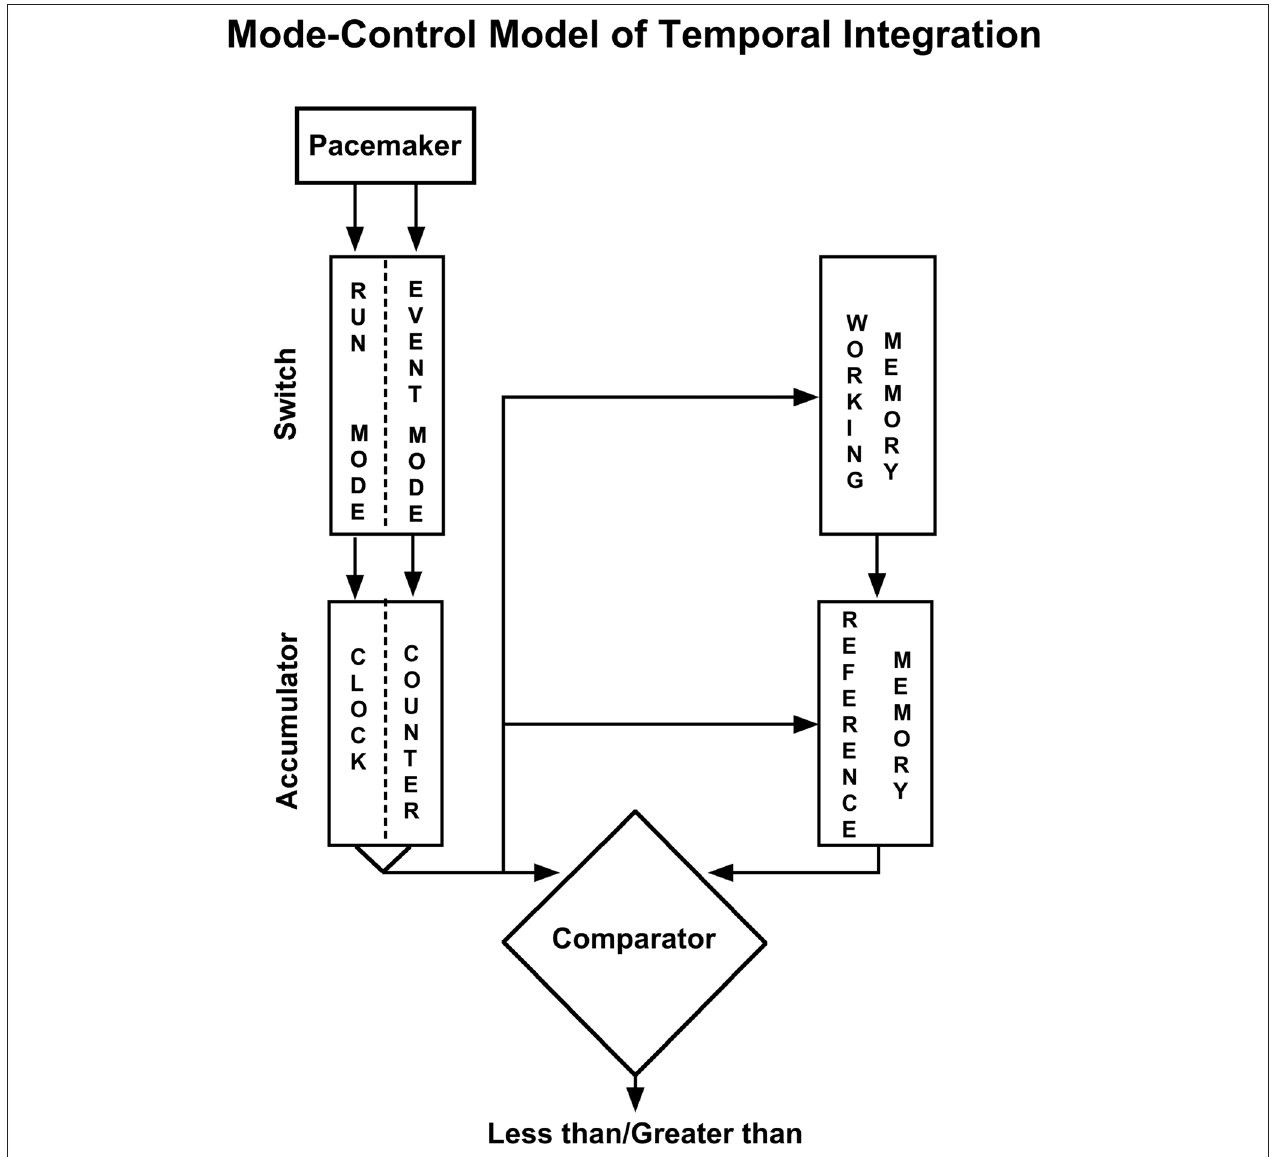
FIGURE 1 | The information-processing “mode-control” model of timing and counting. A pacemaker emits pulses which are gated into an accumulator; it is a counter if operating in the event mode, and a clock if operating in the run mode (see text for details). The current